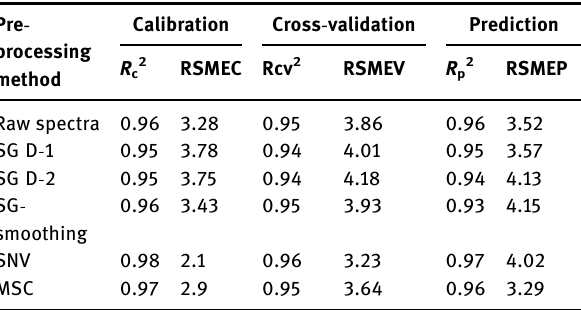
Table 4: Calibration and validation of PLSR models using di ff erent pre - processing methods for predicting maltodextrin percentage in butter fl y - pea extract powder Pre -